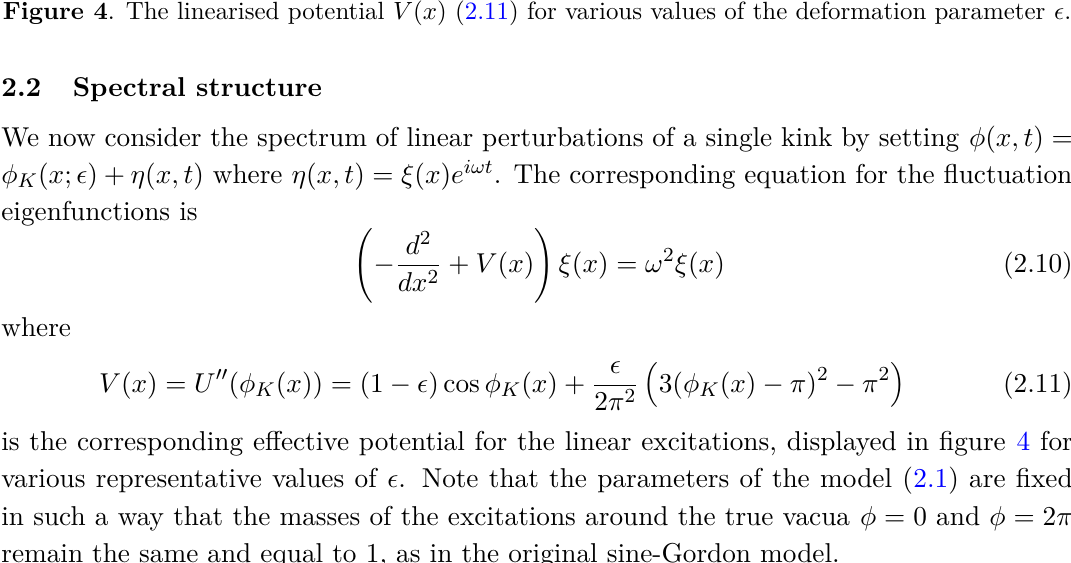
Figure 4 . The linearised potential V ( x ) (2.11) for various values of the deformation parameter (cid:15)